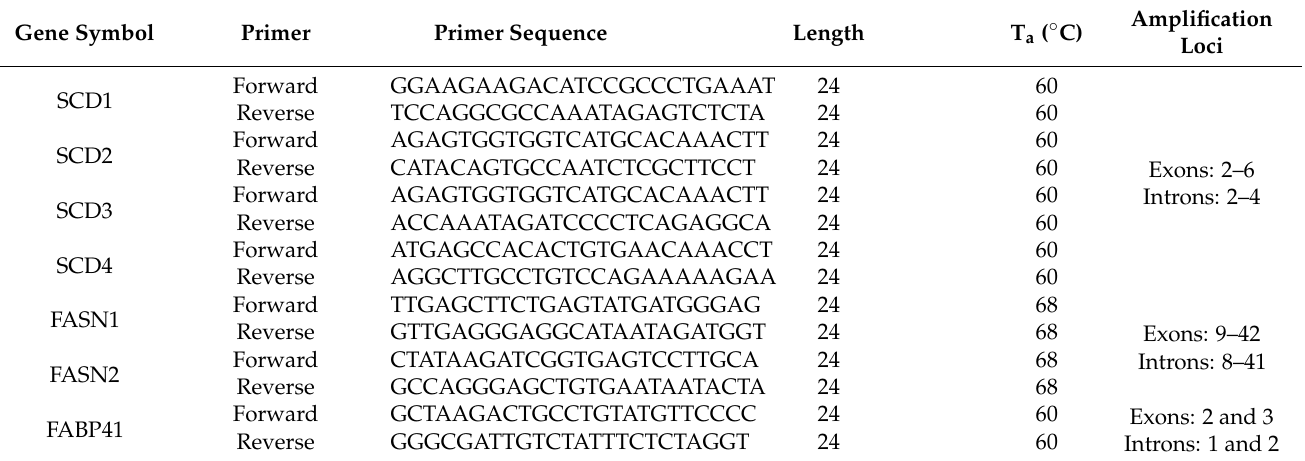
Table 1. Primer pairs and sequences for SCD, FASN, and FABP4 genes for polymerase chain reac- tion assays.